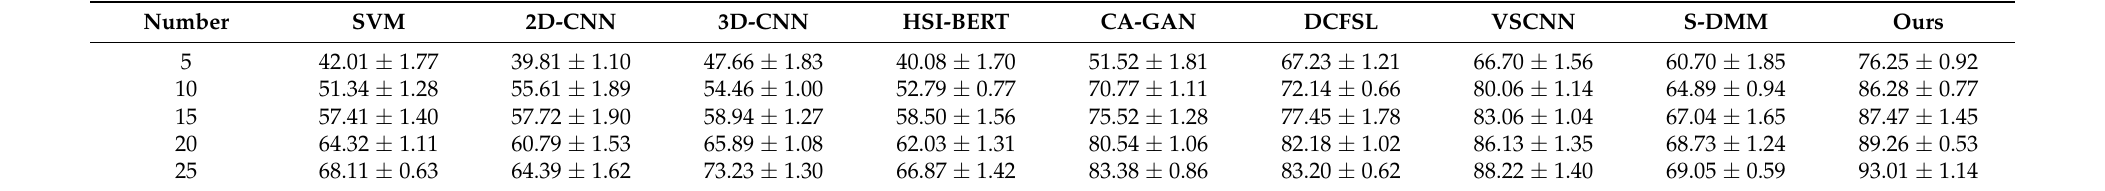
Table 8. The classification results of our proposed and other leading methods on Indian Pines (%).